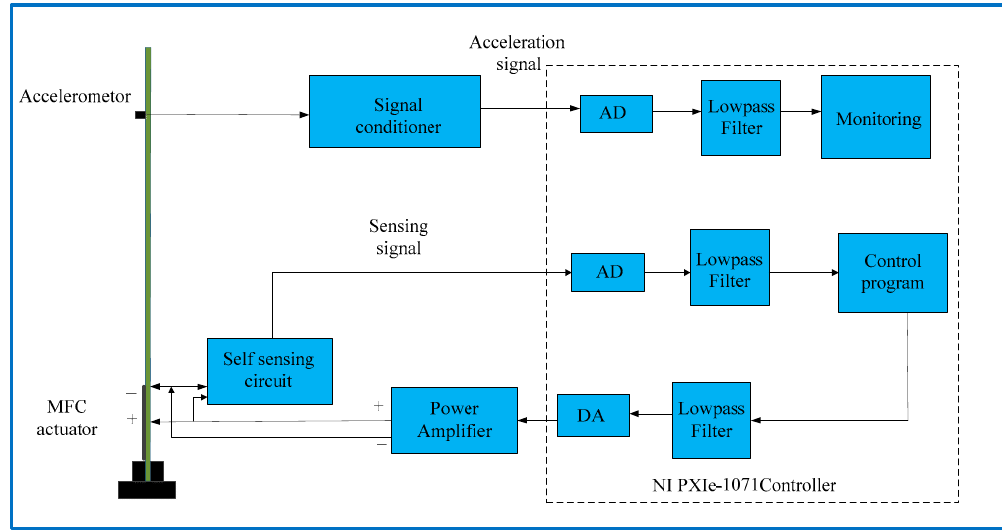
Figure 11. Scene of the wind tunnel test.